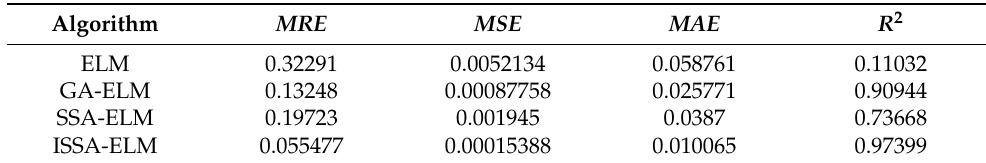
Figure 8. The comparison of fitness curves. Table 7. Comparison of evaluation indexes. Table 7. Comparison of evaluation